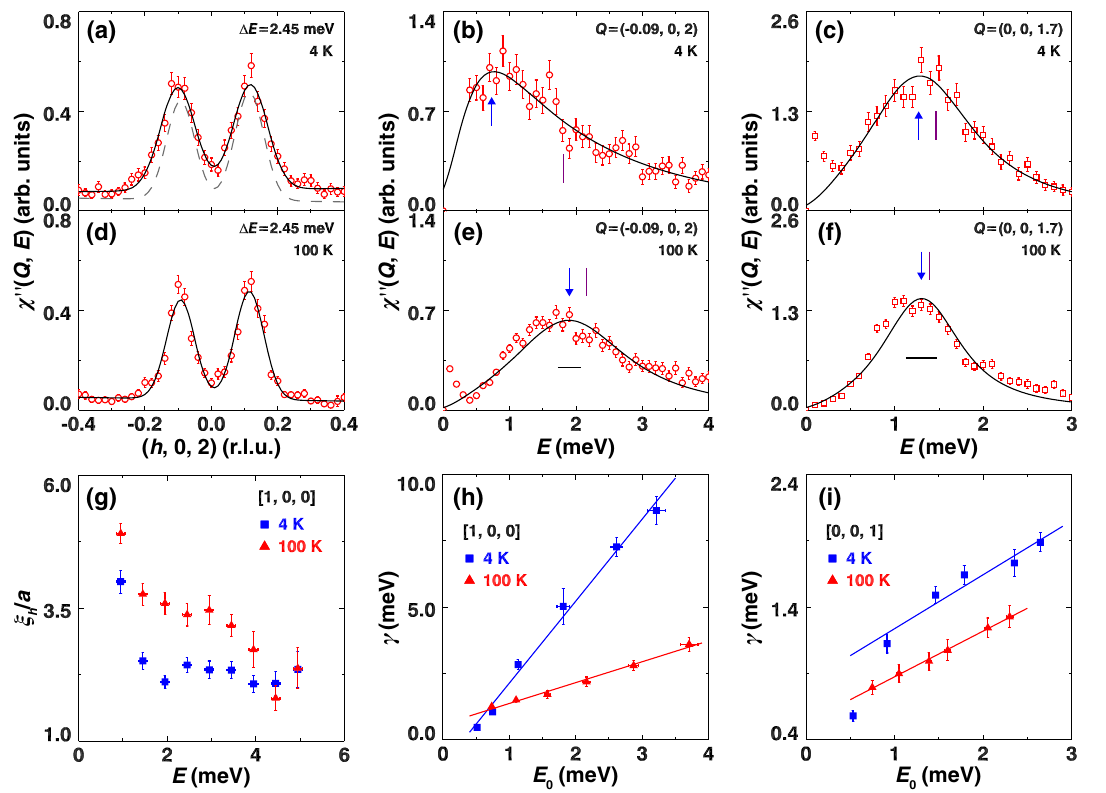
¼ 8 . 9 meV and a i